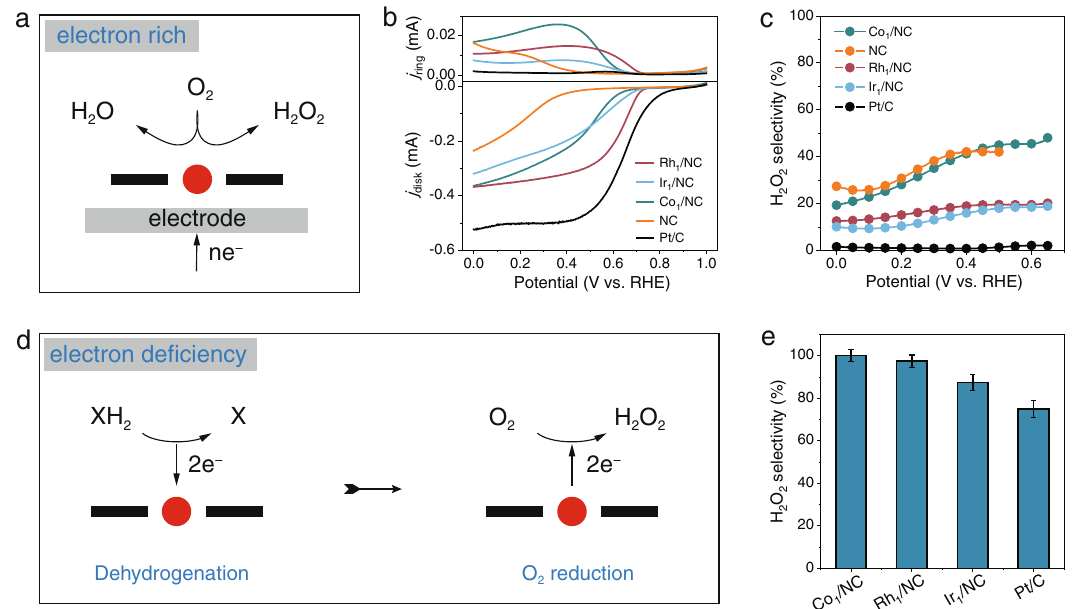
Fig. 5 H 2 O 2 selectivity in the enzymatic and electrocatalytic ORR. a Schematic of the electrocatalytic ORR catalyzed by single-atom catalysts. b Polarization curves at 1600 r.p.m. and simultaneous H 2 O 2 detection currents at the ring electrode in 0.1 M acetate buffer + 0.1 M KCl (pH = 4). c Calculated H 2 O 2 selectivity at various potentials. d Schematic of the dehydrogenation of substrates and the ORR process catalyzed by single-atom catalysts. e H 2 O 2 selectivity in NADH aerobic oxidation in 0.1 M acetate buffer (pH = 4). Data (Fig. 5e) are presented as mean values (SD). (The error bar represents the standard deviation of 3 independent